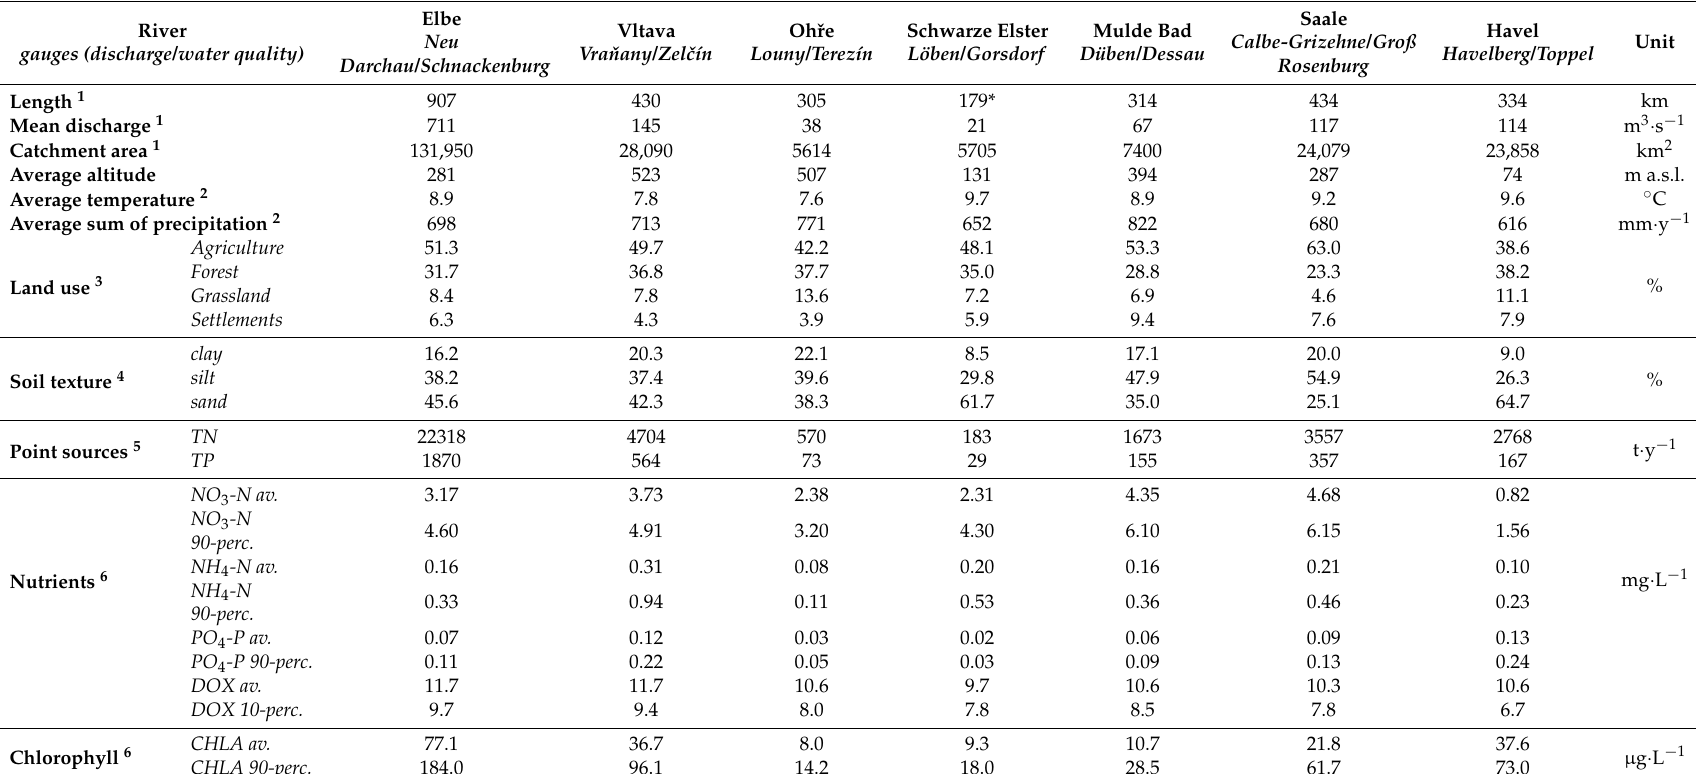
Table 1. Characteristics of the Elbe river catchment and its main tributaries of second (classical) order for the time period